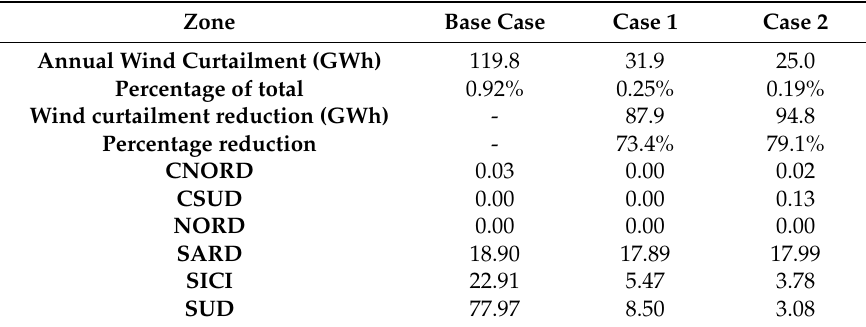
Table 9. Wind curtailment values in the three cases considered.